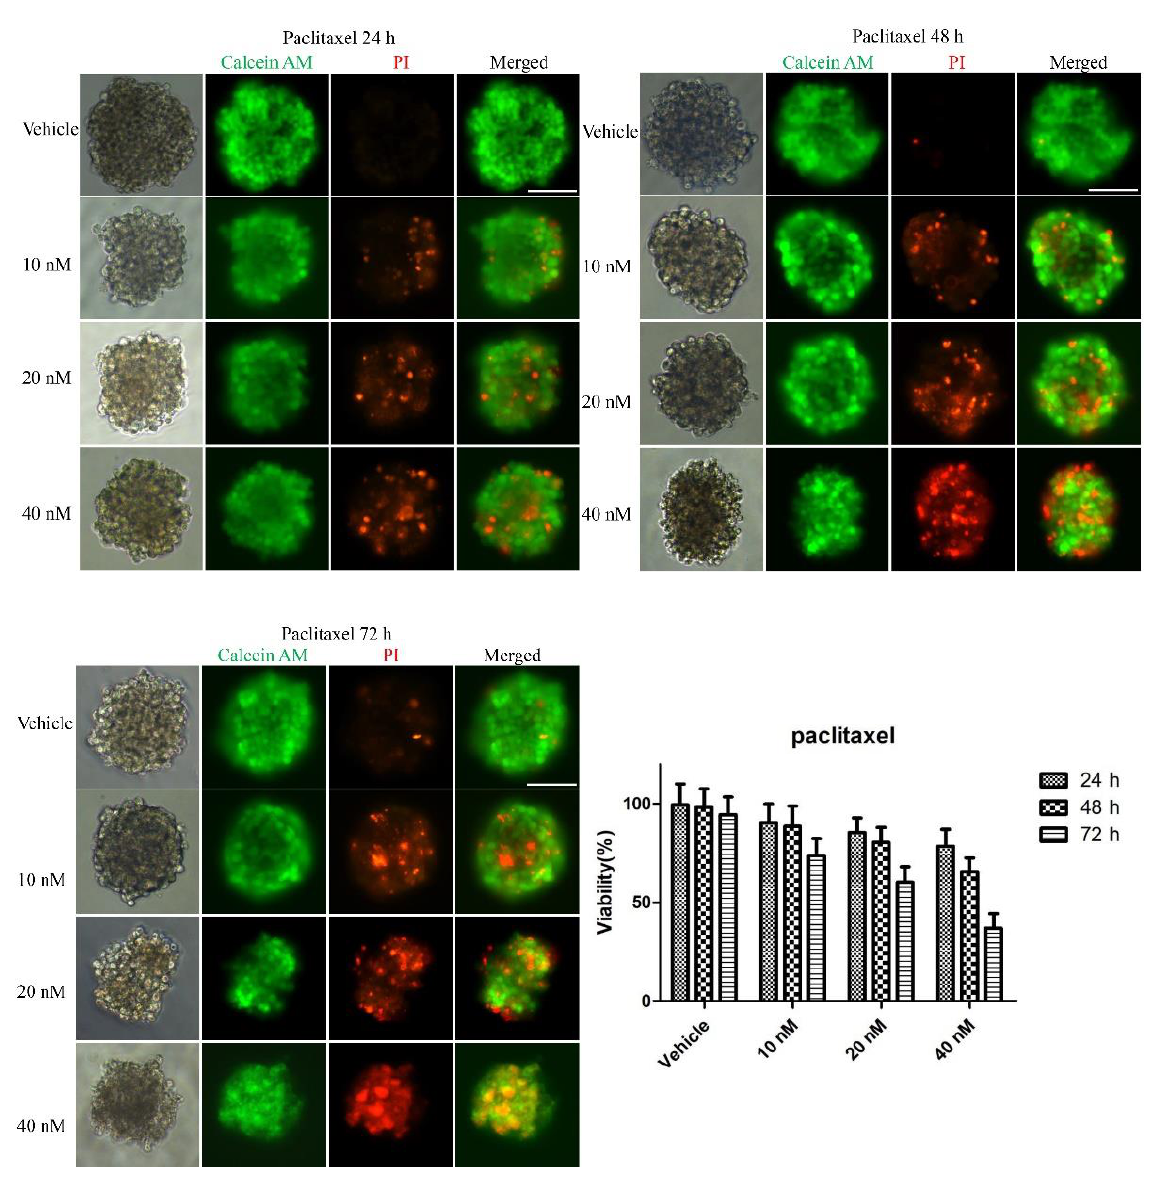
Figure 3. Drug assay (paclitaxel) on tumor spheroids: live/dead cell assay images stained with Calcein AM (green) for viable cells and PI (red) for dead cells. Cell viability decreased over time and concentration. The histogram shows the cell survival rate of the indicated concentrations after 24 h, 48 h and 72 h of the paclitaxel administration (the data are presented as mean ± SD). Magnification = 20×, Bar = 75 µm.